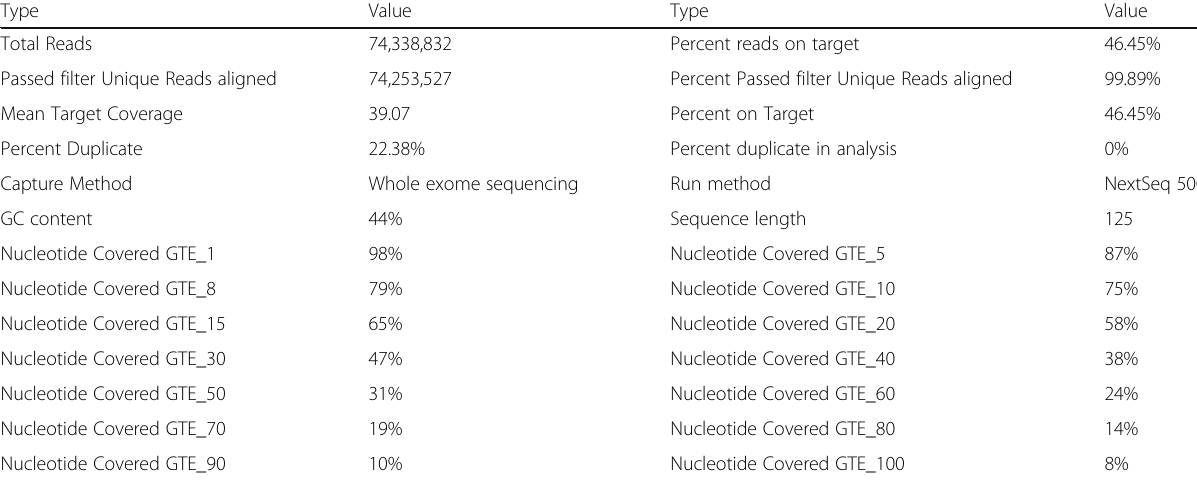
Table 2 Whole Exome Sequencing detail of coverage and number of reads